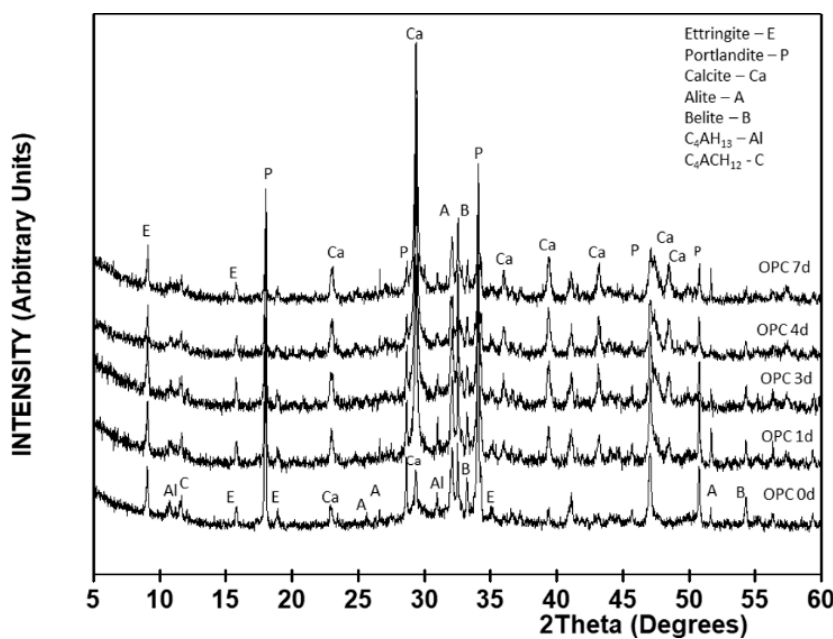
Figure 4. XRD spectra for 0, 1, 3, 4 and 7 days carbonated ordinary Portland cements (OPC) paste.